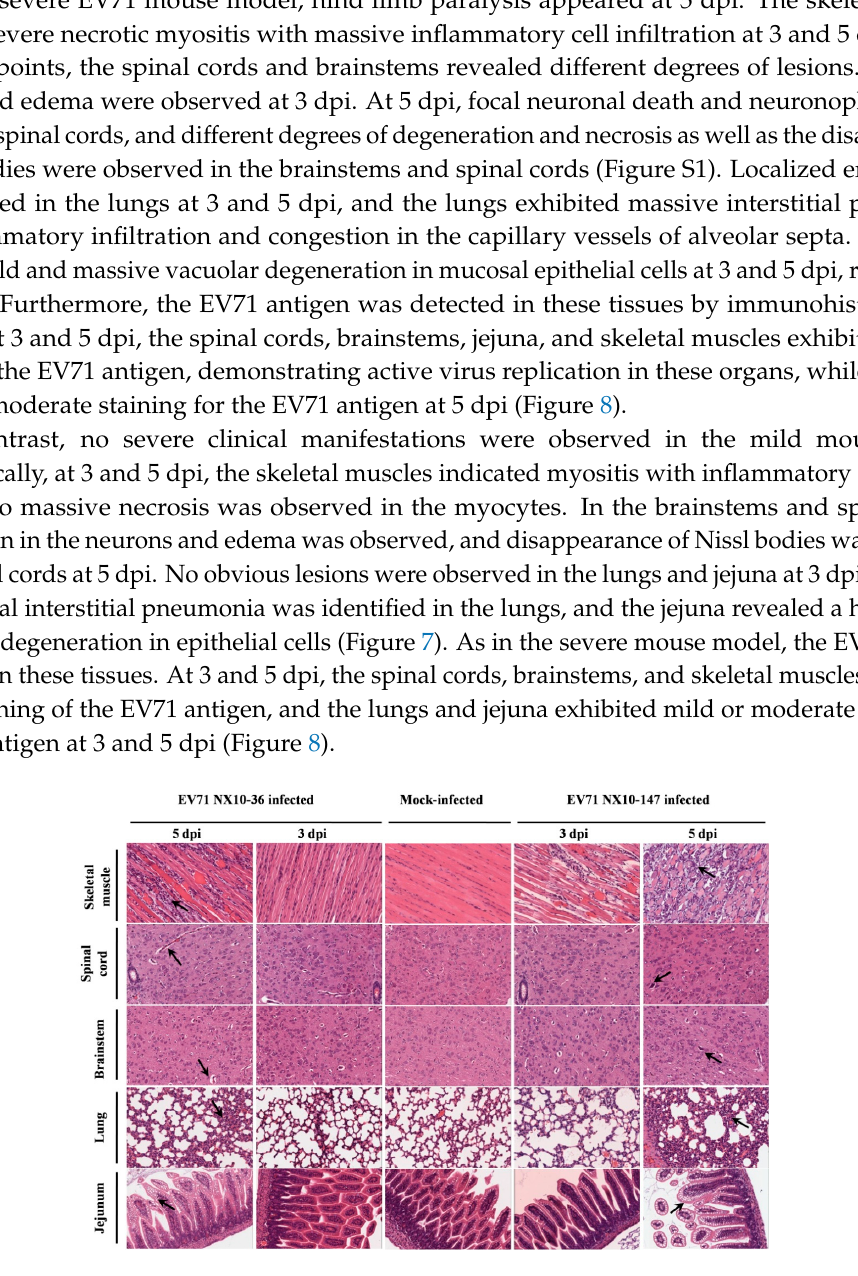
Figure 7. Histological analysis of various mouse tissues. BALB/c mice at nine days of age were inoculated intraperitoneally with 10 4.5 TCID50 of EV71 NX10-147 or NX10-36, and the mice were sacrificed at the indicated time points (3 mice each). Tissues were removed, and tissue sections were subjected to hematoxylin-eosin staining, followed by histopathological examination by light microscopy. The data shown are representative images of each group of mice at 3 and 5 dpi (magnification 200 × ). The arrows indicate the typical characteristics of the lesions in different tissues at 5 dpi. There were no obvious pathological features in these tissues in the control